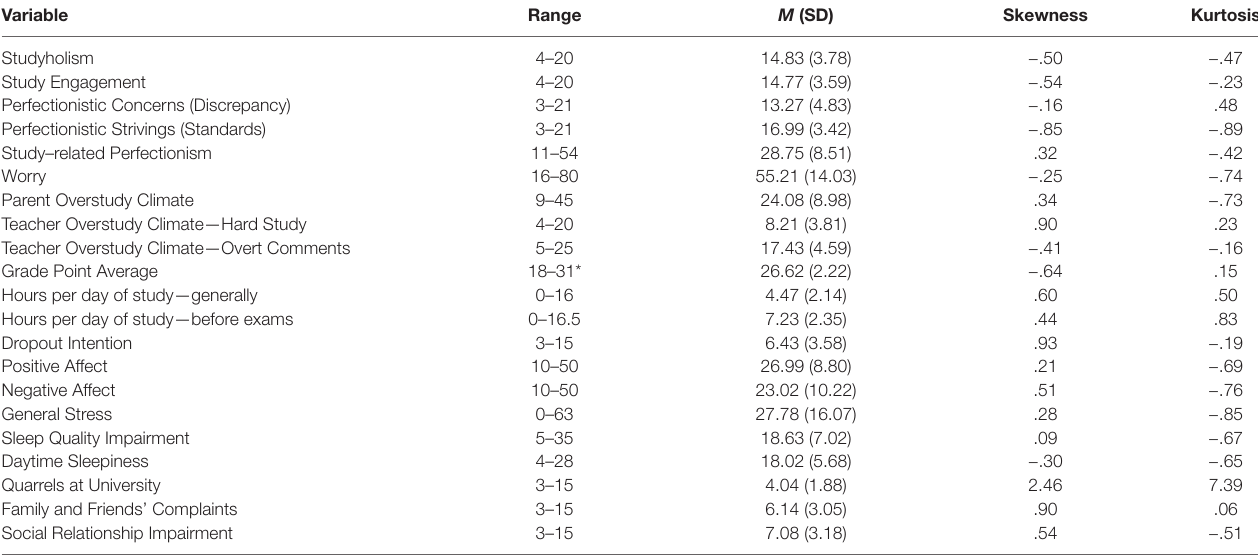
TABLE 3 | Descriptive statistics of all the variables in the model (n = 1,958).